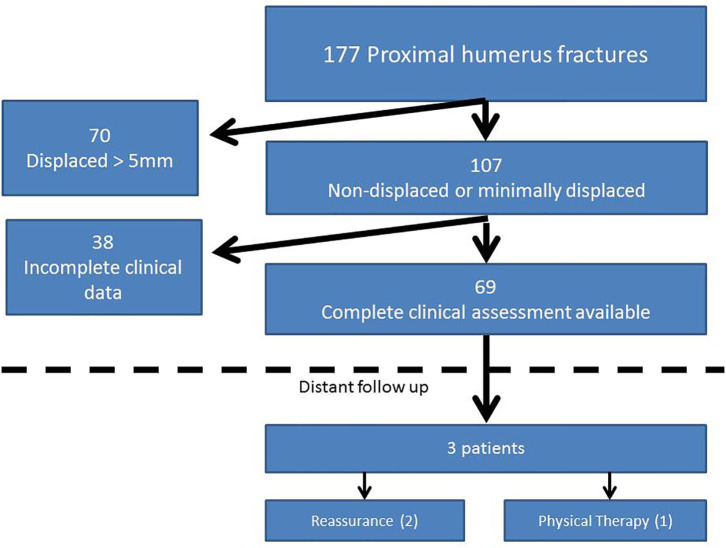
Subject inclusion breakdown.